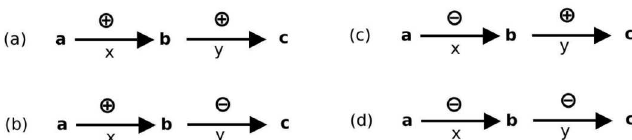
Figure 5. Four types of direct chains: (a) pro-pro, (b) pro-contra, (c) contra-pro, and (d) contra-contra